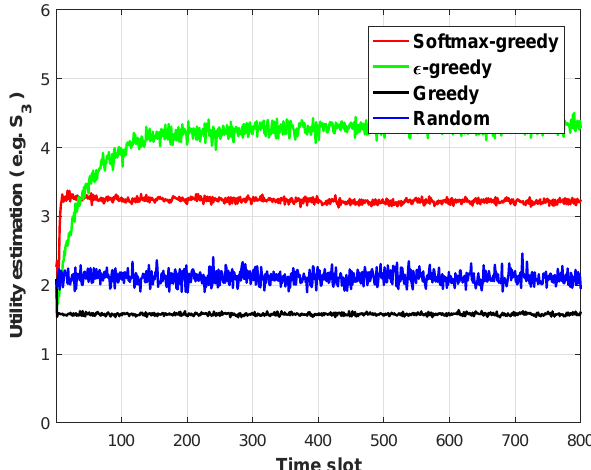
Figure 4. Comparison of utility values under different power control